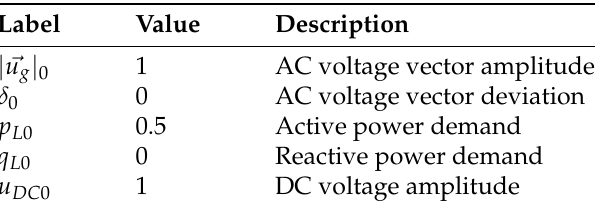
Table 3. Base case operating point in p.u.